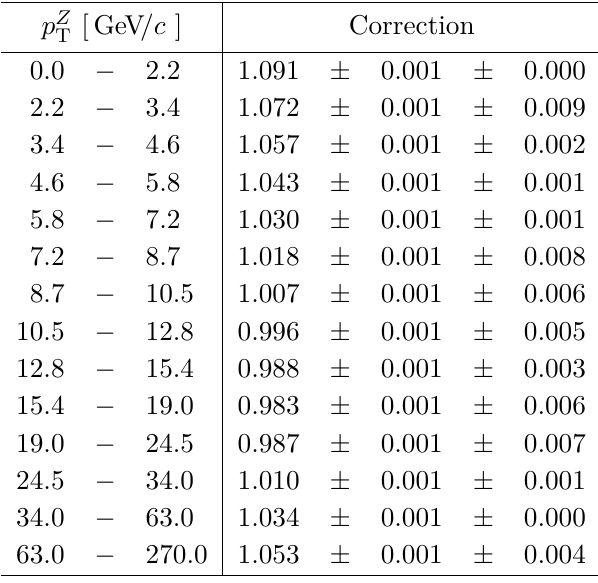
Table 3 . Final state radiation correction used in the p Z uncertainty is statistical and the second is systematic.